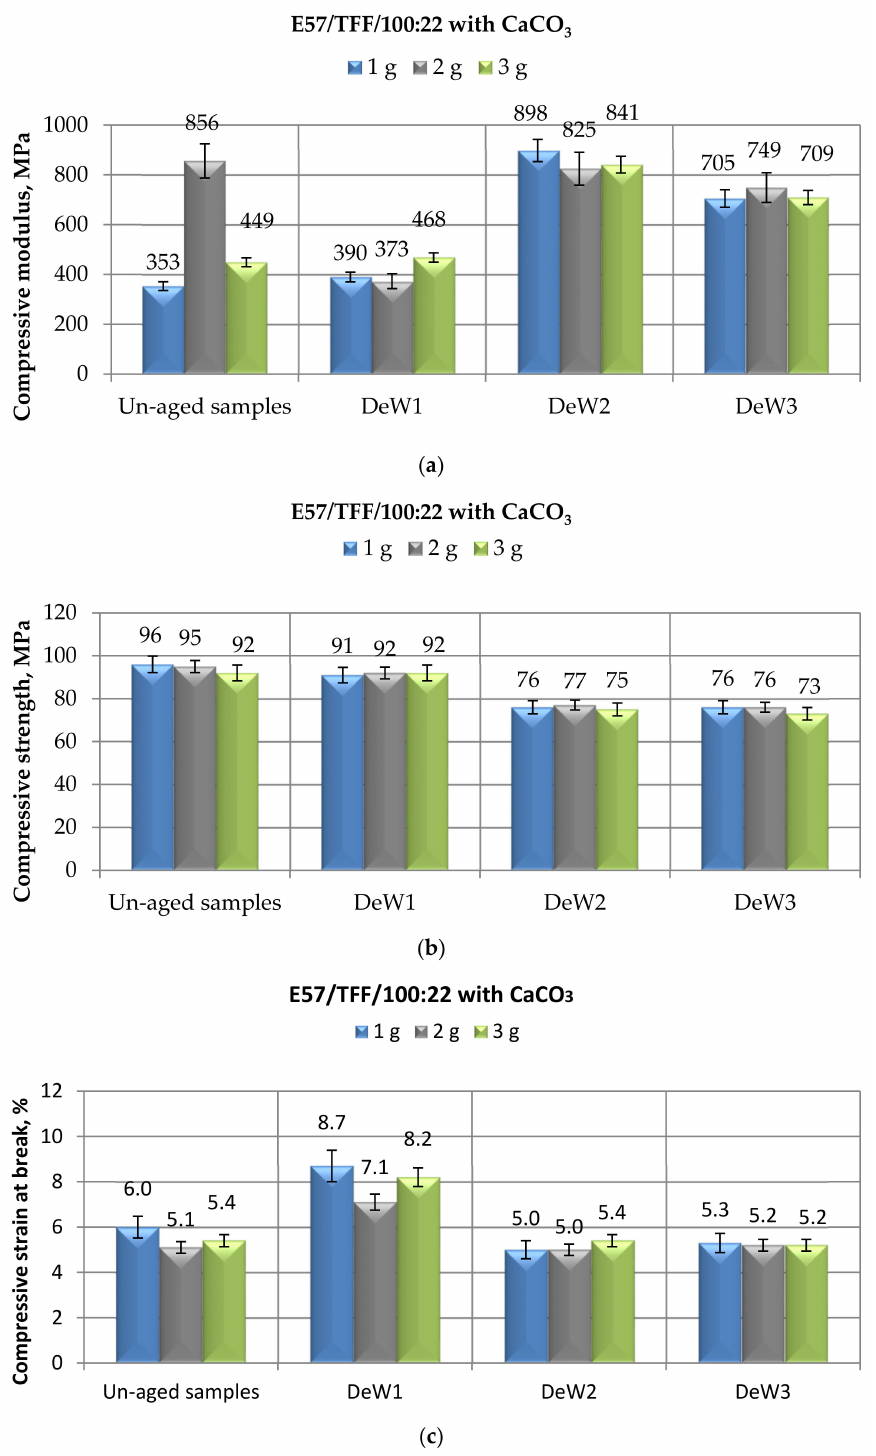
Figure 3. Results of mechanical tests performed in compression mode on CaCO 3 -filled E57/TFF/100:22 specimens after different immersion times (i.e., 1, 6, and 10 months) in demineralized water, in terms of ( a ) Compressive modulus; ( b ) Compressive maximum strength; ( c ) Compressive strain at